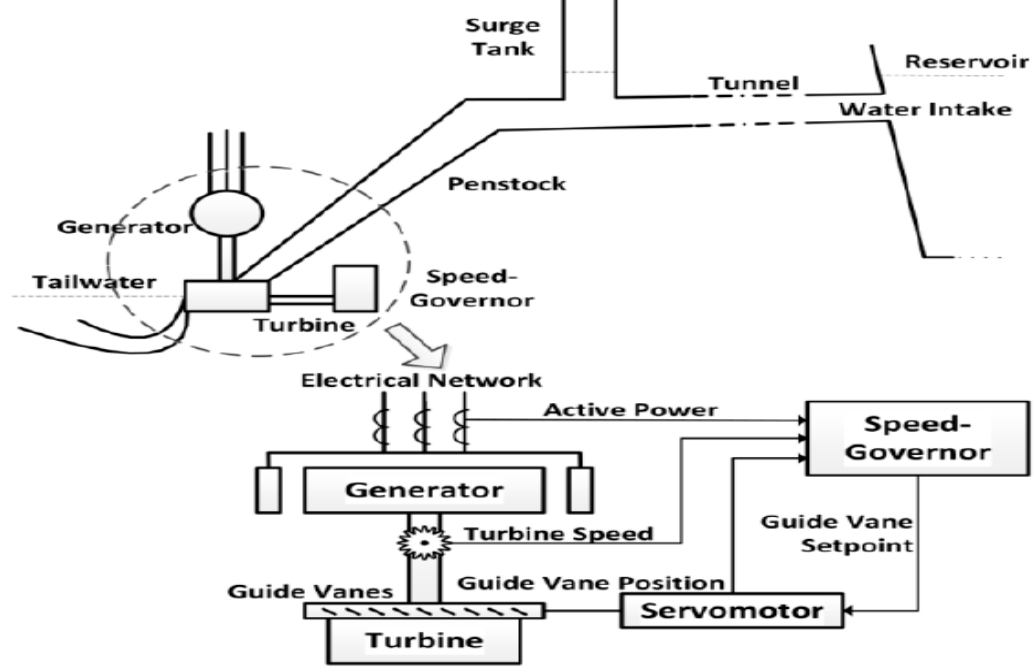
Figure 4. General layout of a hydropower plant.